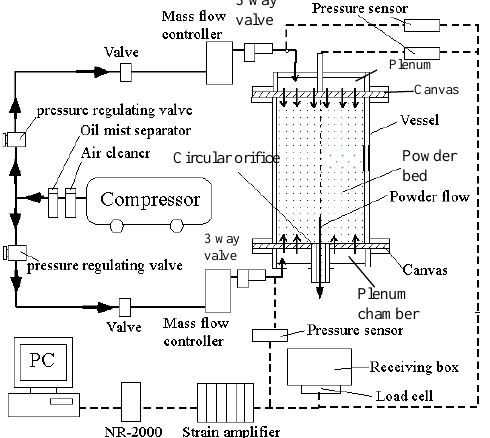
Fig. 1. Experimental apparatus.